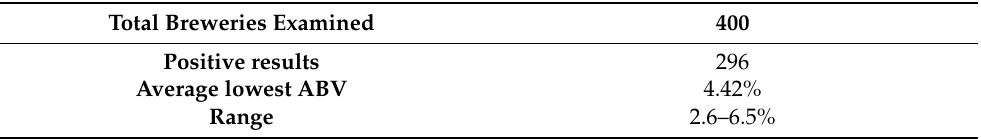
Figure 2. Map of included breweries’ locations and lowest ABV on offer. (Map by AUTHOR and Heather Swienton; 17 November 2022). Table 1. Summative ABV data; the range provided excludes the two outliers (two beverages with 0% and 10% ABV) in order to provide a more accurate sense of the real landscape of these low(er) ABV offerings. ( Data from the authors).